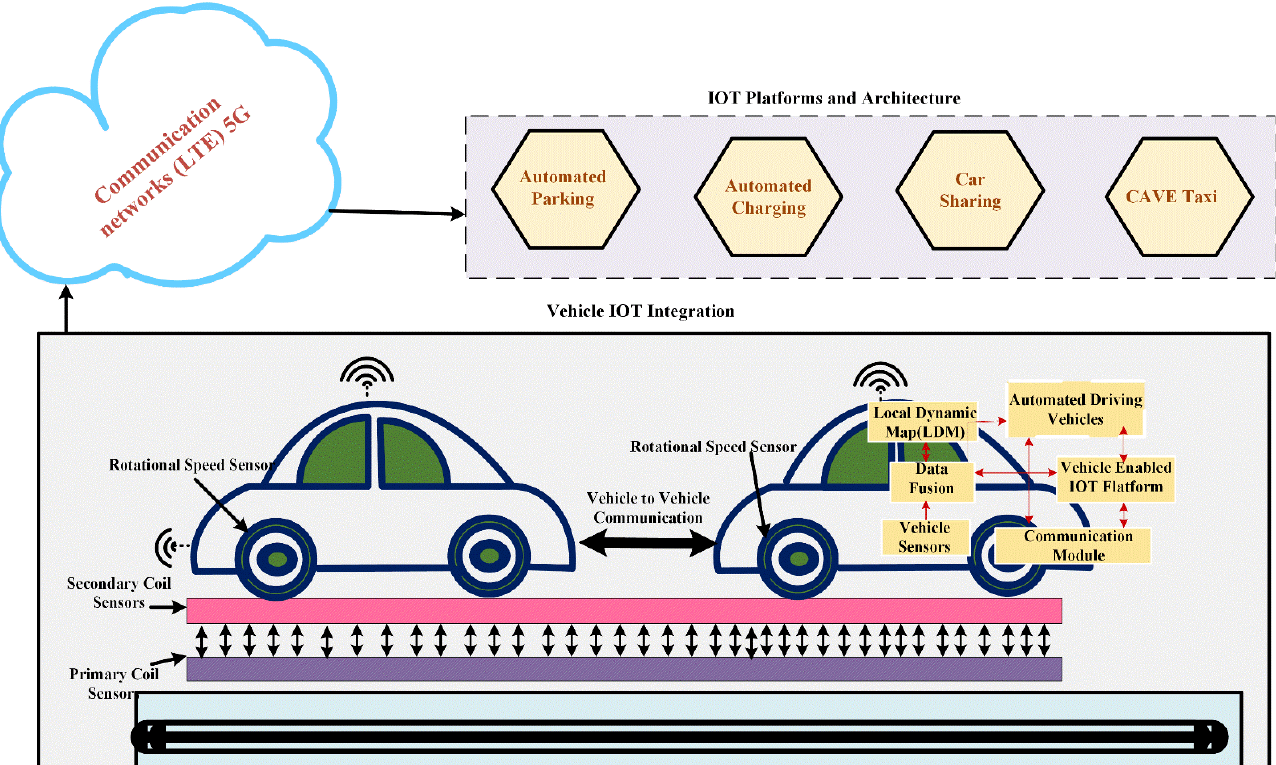
Figure 19. Internet of Things (IoT) for an Electric Vehicle interface.